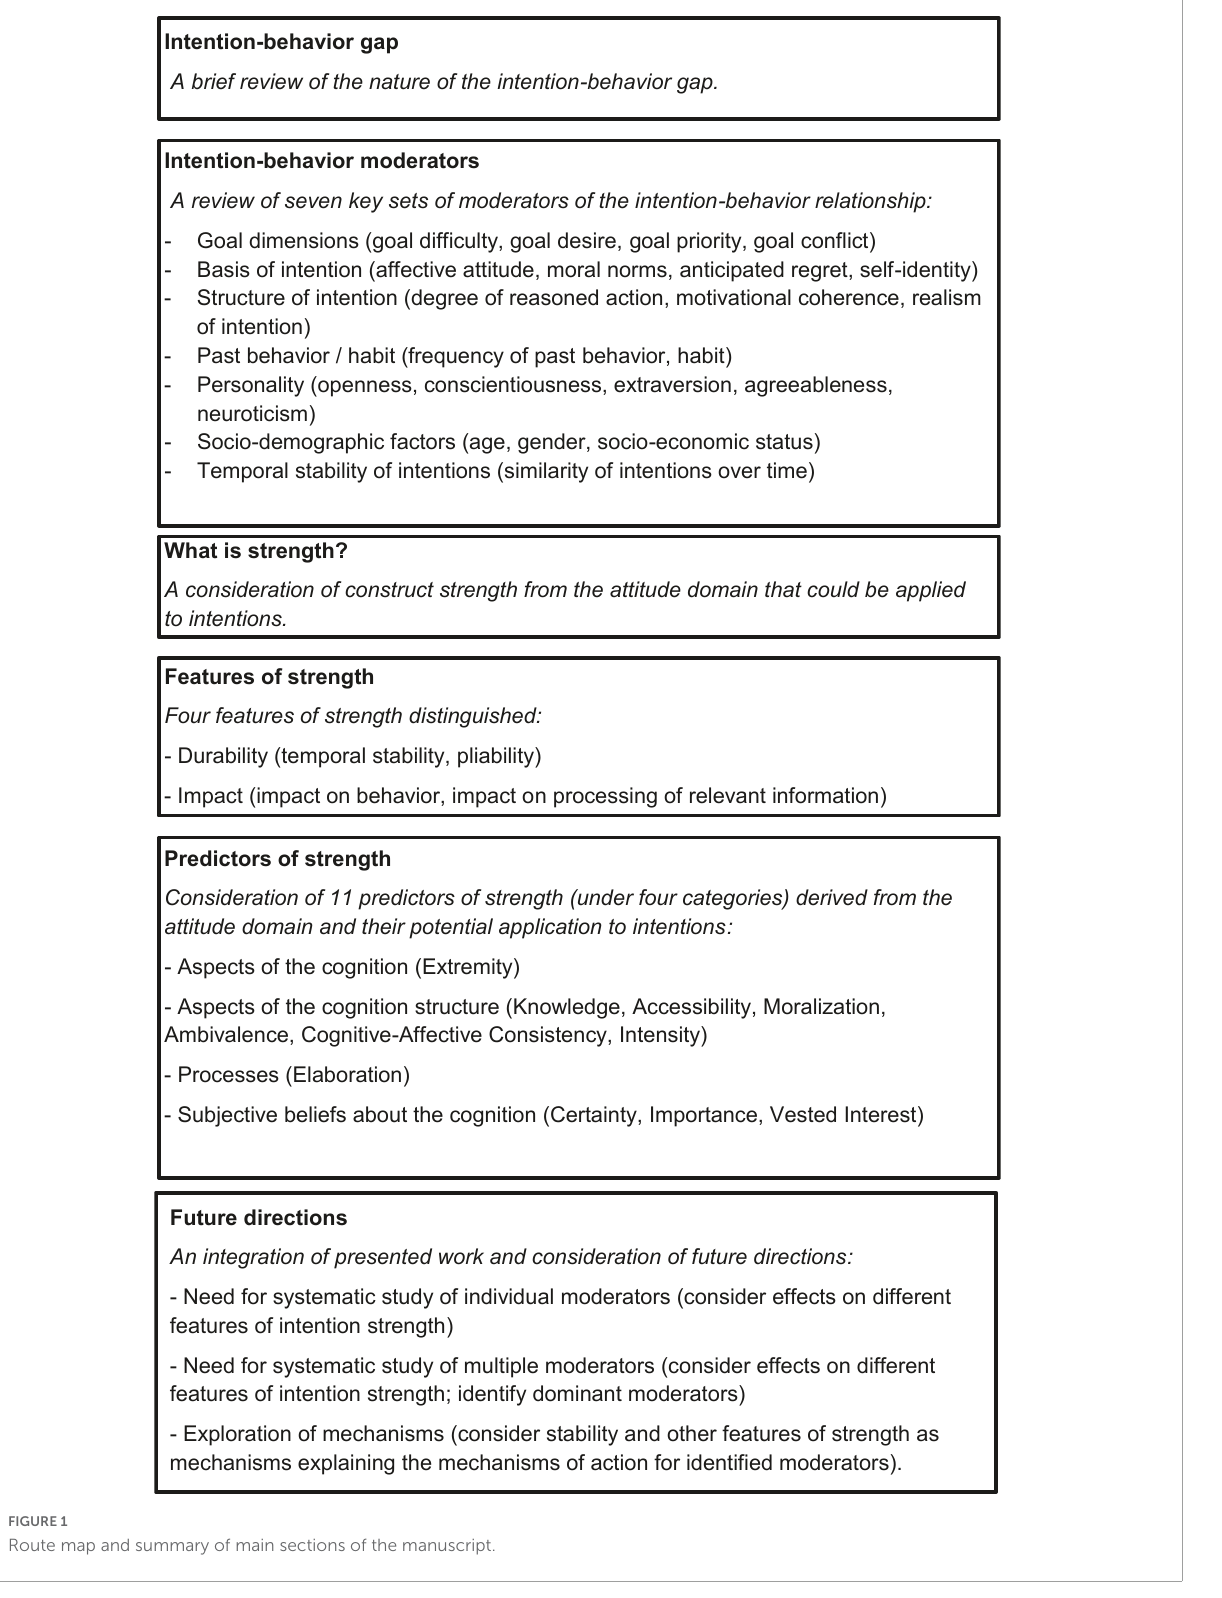
FIGURE1 Route map and summary of main sections of the